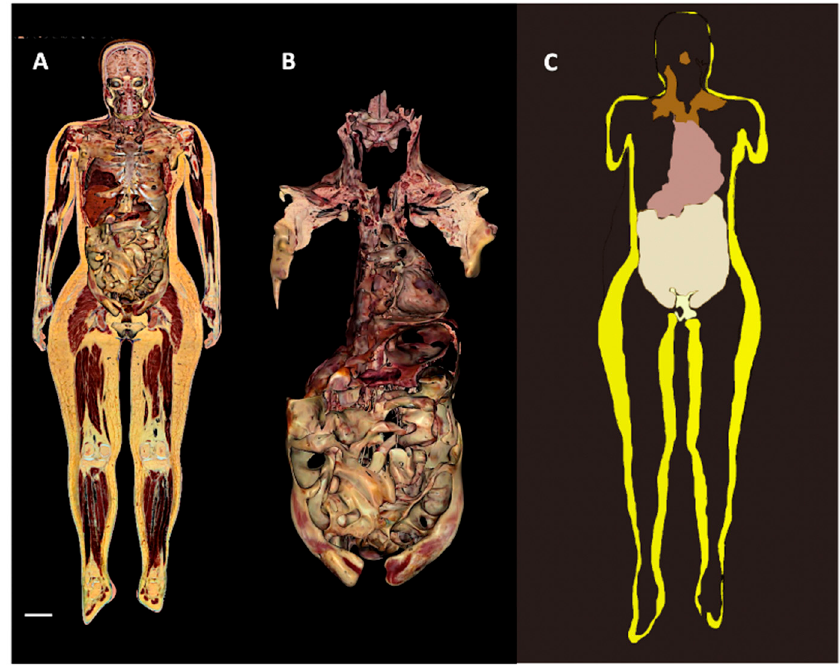
Figure 7. 2D and 3D reconstructions of human Adipose Organ. Digital cadaver Vicky. ( A ): Repre- sentative images showing the whole adipose organ in a coronal section, ( B ): the 3D reconstruction of isolated visceral fat in connection with the supraclavicular-axillary part of the adipose organ, and ( C ): the visceral (brown, beige, and pale white) and subcutaneous (yellow) parts of the adipose organ (still image from S Movie 1). Bar: 65 mm in ( A ), 35 mm in ( B ) and 75 mm in ( C